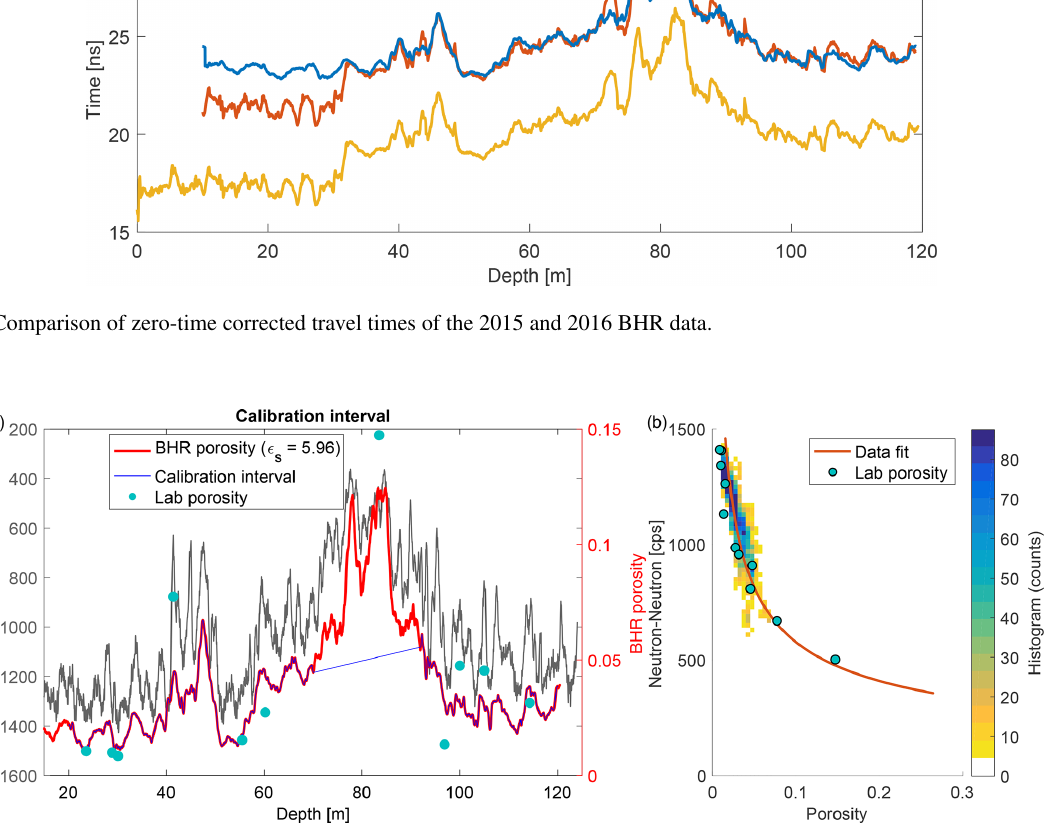
Figure A3. (a) Neutron–neutron counts and best-fitting BHR porosity. (b) Fitted relation between the neutron–neutron and the BHR porosity overlaying a corresponding histogram crossplot.